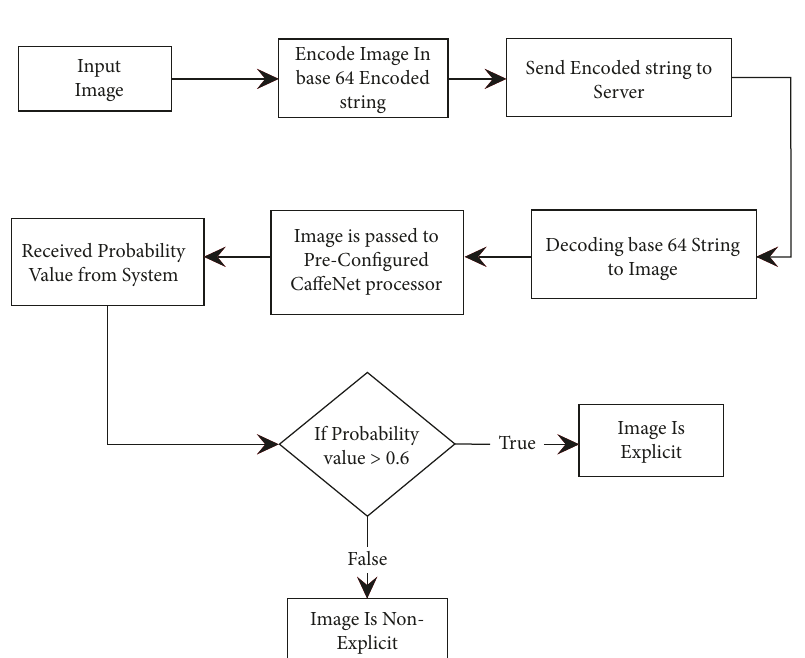
Figure 3: Sending images to